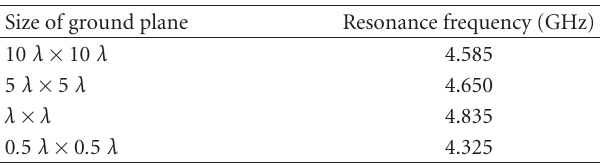
Figure 3: Folded slot forward and backward side. Table 1: Slot antenna resonance frequency by changing the size of ground plane (measurement).